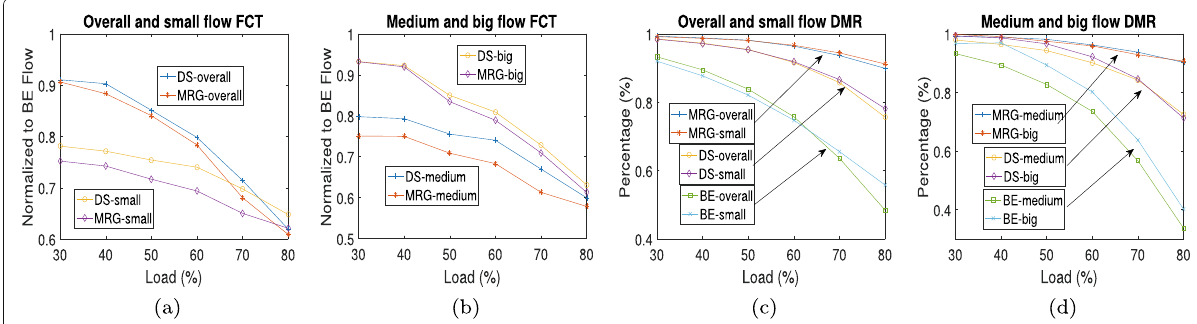
Fig. 8 VBP with Websearch workload: ( a ) overall and small flow FCT; ( b ) Medium and big flow FCT; ( c ) Overall and small flow DMR; and ( d ) Medium and big flow